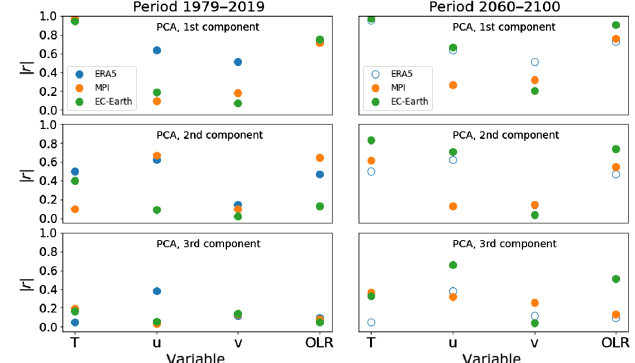
FIG. 14. First row: correlations (in absolute value) between the first PC of each variable (on the x axis) and the multivariate case in ERA5 and models. Second and third rows: same as first row but for the second and third Isomap